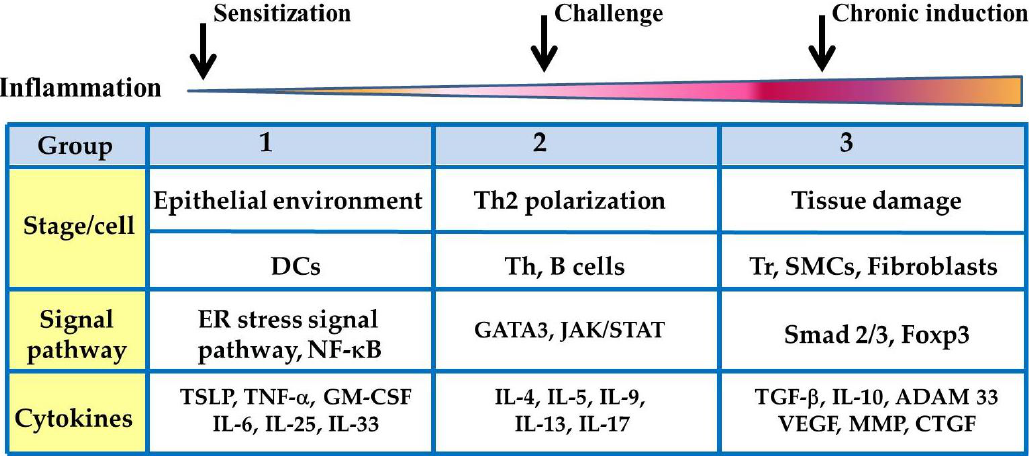
Figure 2. Three stages for cytokine therapeutic strategies of